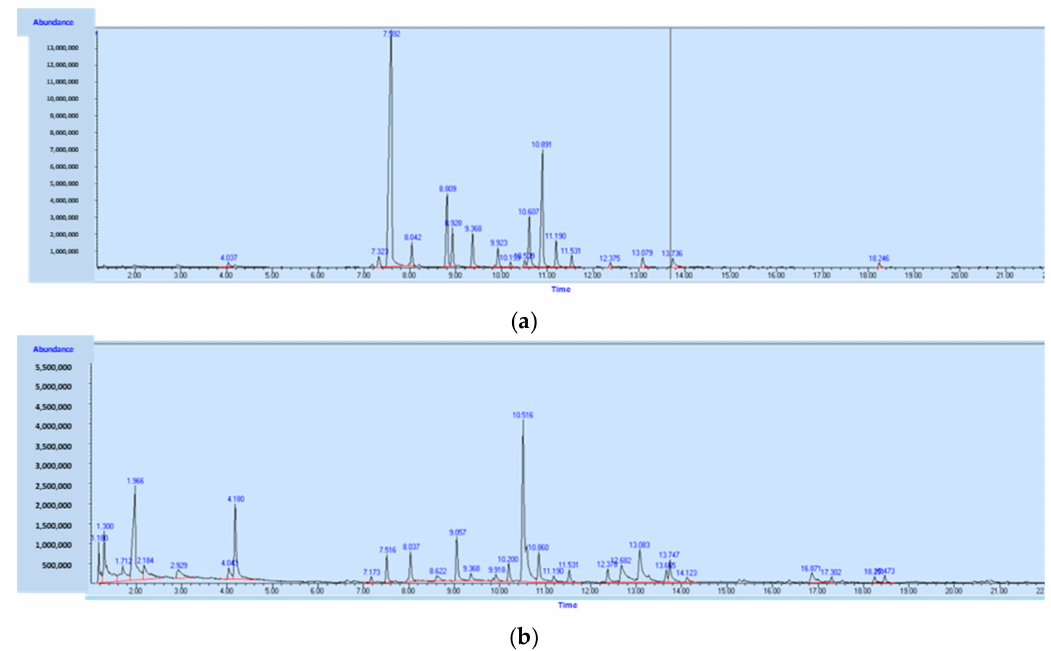
Figure 1. Chromatograms resulting from solid-phase microextraction (SPME)–GC–MS analysis of the crushed seeds headspace using two di ff erent fiber coatings: ( a ) carboxen / polydimethylsiloxane (PDMS) (75 µ m) and ( b ) PDMS / divinylbenzene (DVB) (65 µ m) (T, 23 ◦ C; t adsorption , 30